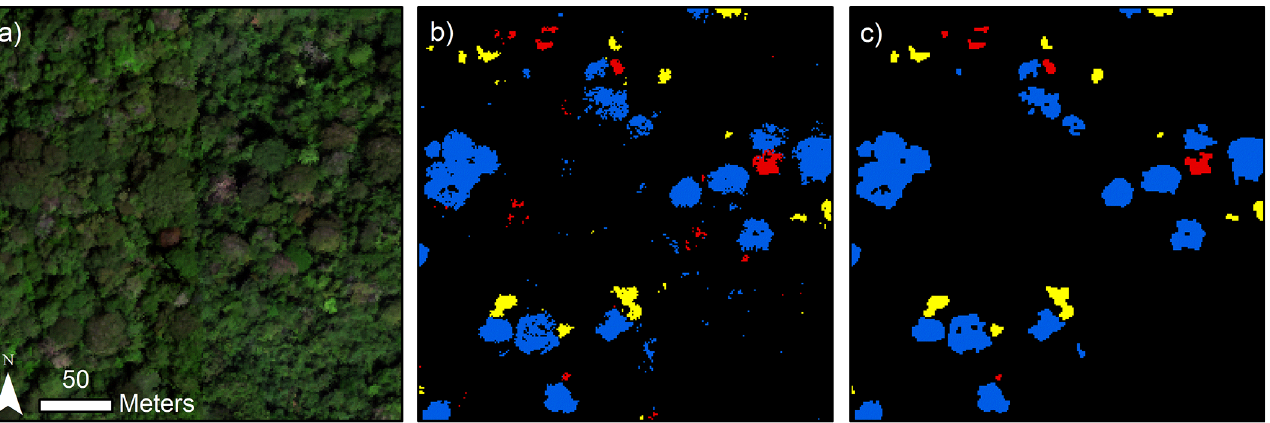
Fig 5. Mapped results of the multi-species model before and after applying the contextual filters. The panels are (a) true-color representation of the raw imagery, (b) prediction results for the multi-species classification model, and (c) prediction results after undergoing crown smoothing and size filtering. The three spectral bands used to display the true-color image in (a) are R = 640 nm, G = 550 nm, and B = 460 nm. The colors used to represent the species in (b) and (c) are blue = D . panamensis , red = H . guayacan , and yellow = J . copaia .